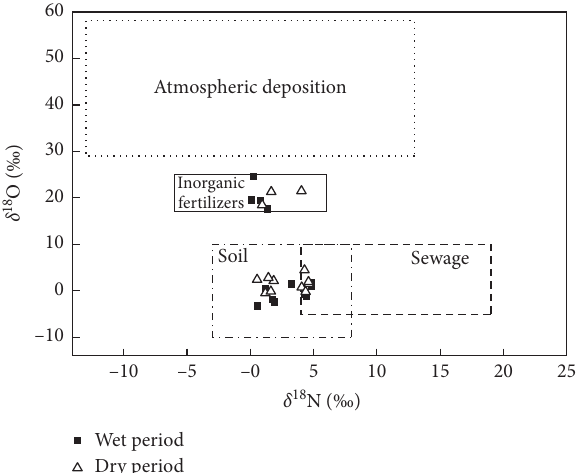
Figure 4: Distribution of typical and measured values of δ 15 N and δ 18 O for different sources of the nitrate.